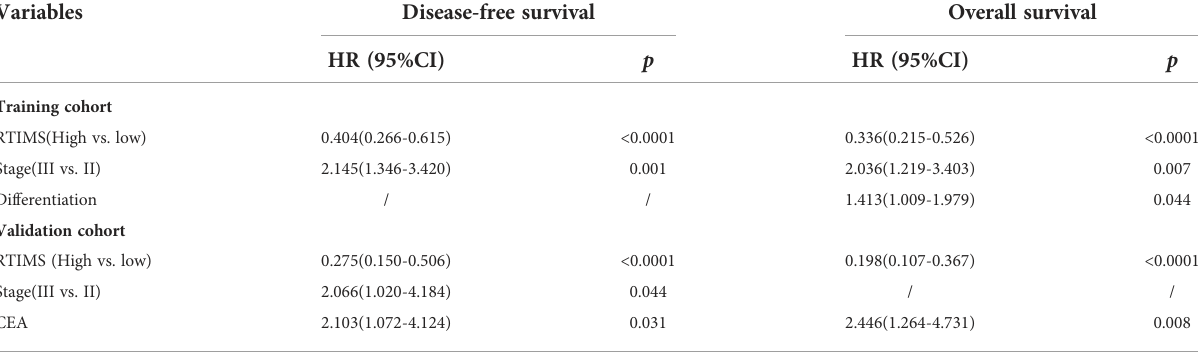
TABLE 2 Multivariate Cox Regression analyses for disease-free survival and overall survival in the training cohort of patients with gastric cancer. Variables Disease-free